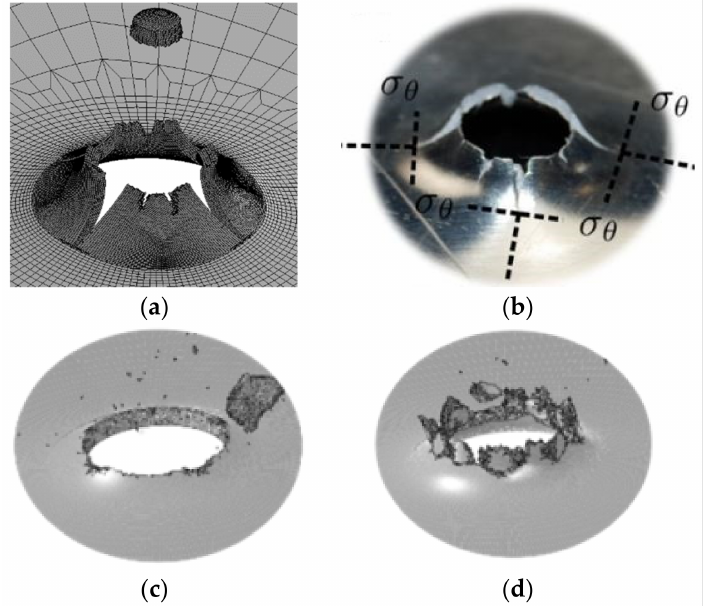
Figure 26. Comparisons of the model predictions with experimental observation for the perforation of 4-mm-thick 2024-T351 aluminum alloy-plated struck transversely by a 7.5-mm-diameter spherical projectile. ( a ) The present model; ( b ) the experimental observation [53]; ( c ) the JC constitutive model with the JC failure criterion [53]; and ( d ) the JC constitutive model with the BW fracture criterion [53]. Adapted from [53], with permission from MDPI,